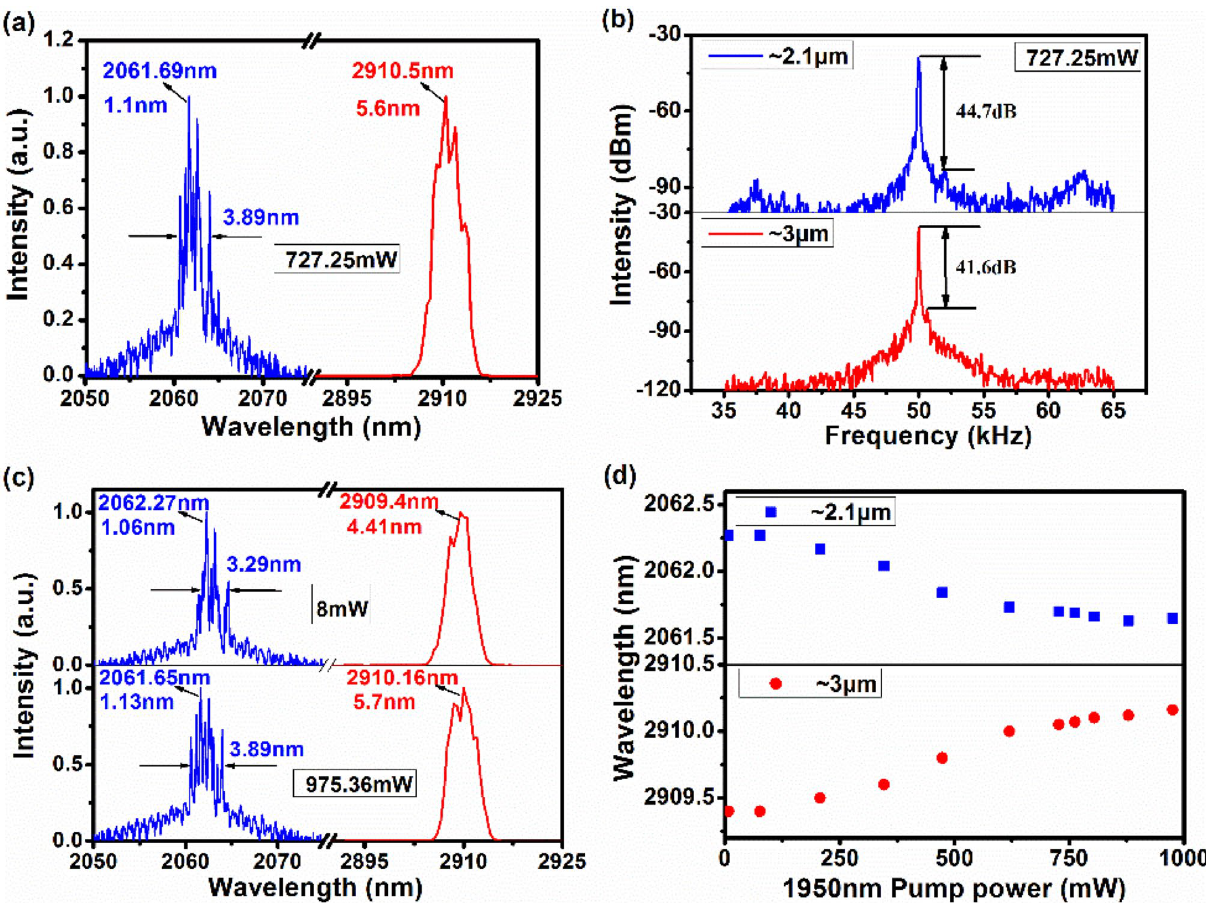
Figure 3. ( a ) The optical spectra and ( b ) the RF spectra of the dual-waveband gain-switching at the 1950 nm pump power of 727.25 mW, ( c ) the optical spectra of the dual-waveband lasers at the 1950 nm pump power of 8 mW and 975.36 mW, ( d ) the center wavelengths of the ~ 3 μm and ~ 2.1 μm lasers as a function of the 1950 nm pump power with the 1150 nm pump power fixed at 3.295 operated in a single wavelength with multiple peaks while multiple wavelengths were involved in the ~ 2.1 µm optical spectrum with a spectral FWHM bandwidth of 3.89 nm measured at half of maximum intensity level.